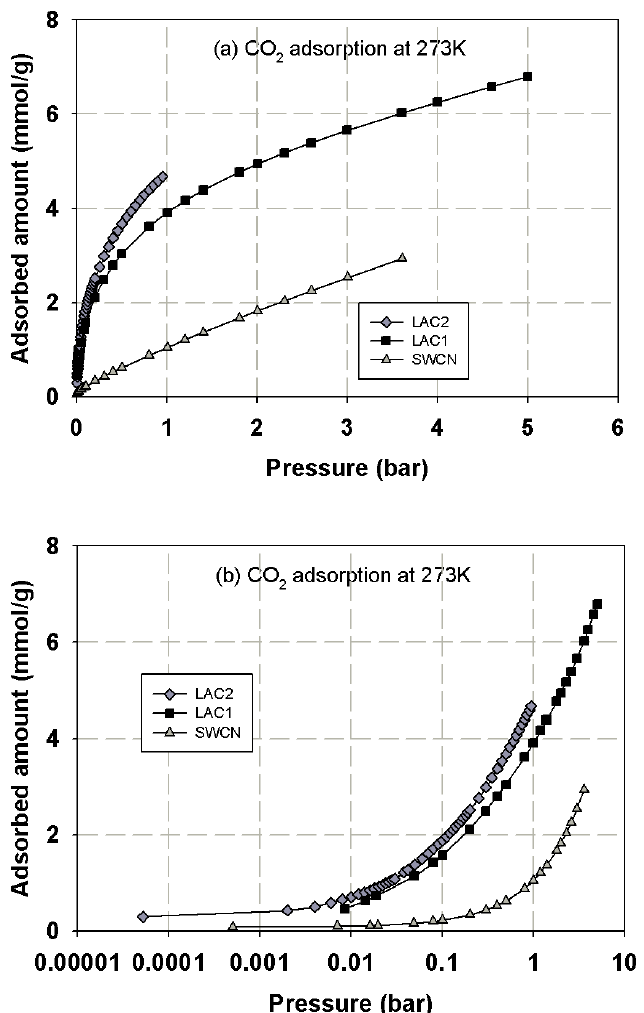
Figure 4. Adsorption isotherms of methane in activated carbons and single wall carbon nanotube at 300 K in linear ( a ) and semi-log ( b ) scales.